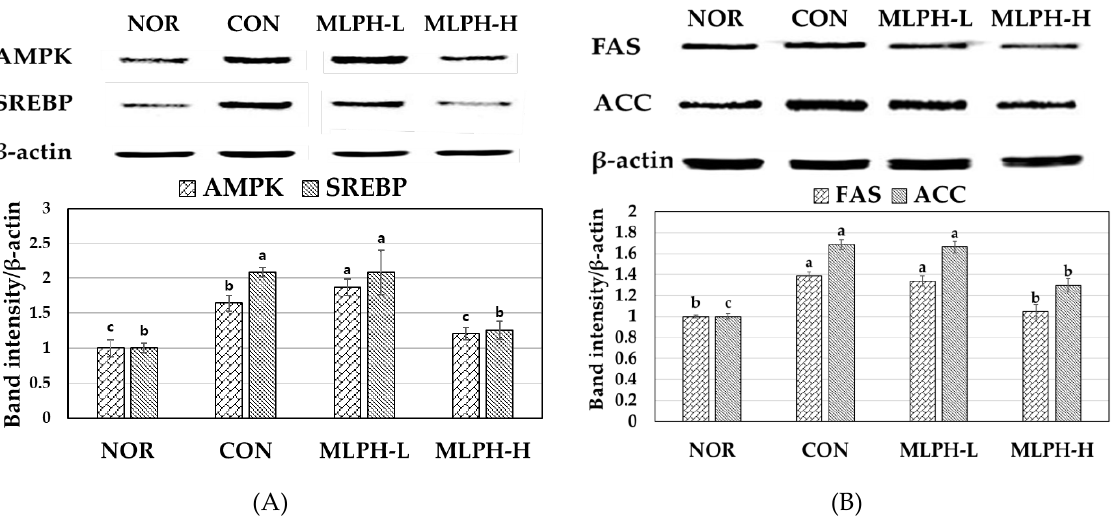
Figure 6. Effects of MLPH extract on protein expression levels of (A) AMPK and SREBP, and (B) FAS and ACC in liver tissue of normal and experimental ob / ob mice. Each value represents the mean ± SEM ( n = 6). a-c Values not sharing a common letter are significantly different at p < 0.05 by Tukey’s multiple comparison test.